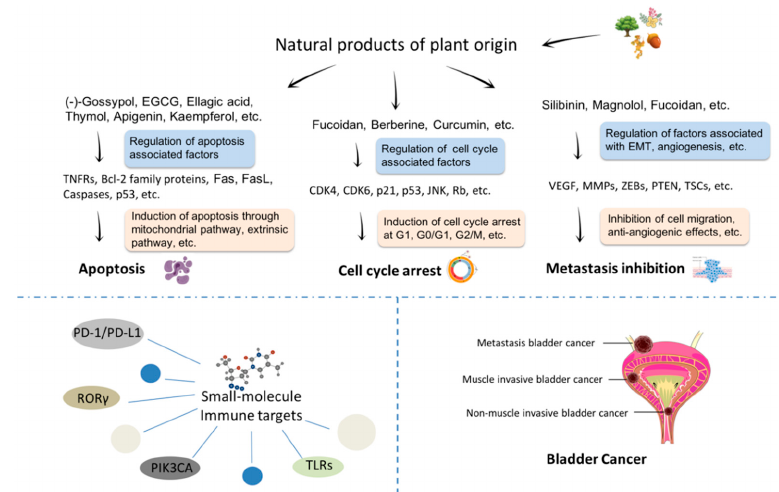
Figure 1. The main mechanisms and potential small-molecule immune-targets of promising plant-origin natural products for bladder cancer treatment.